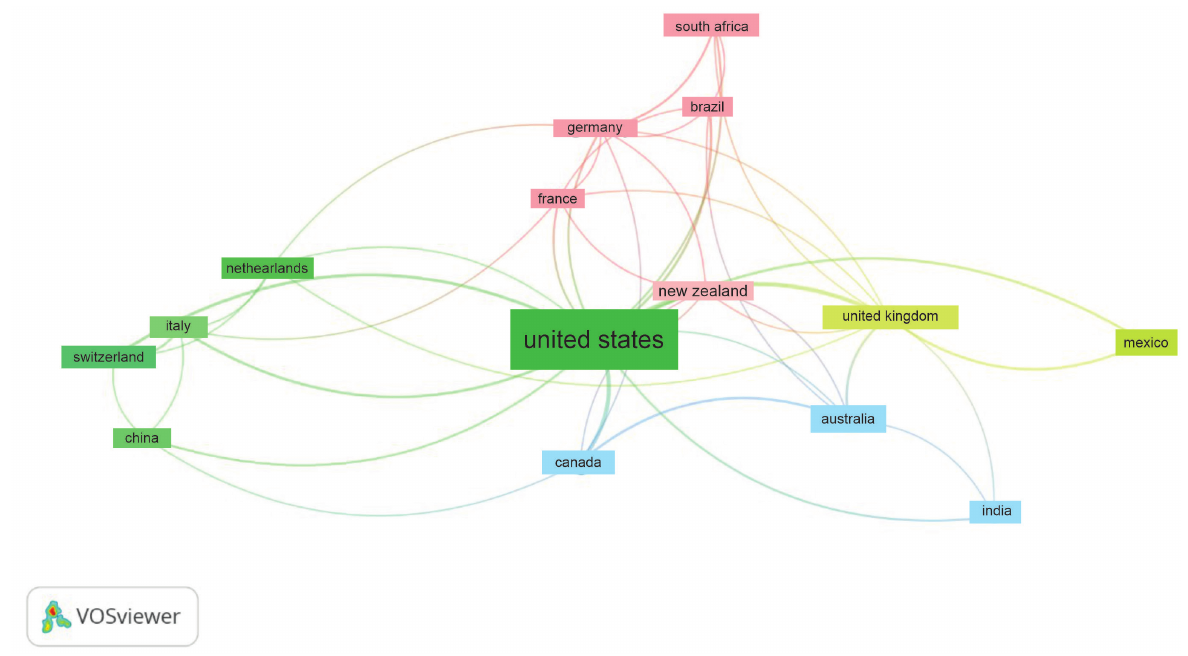
Figure 4. Citation mapping between